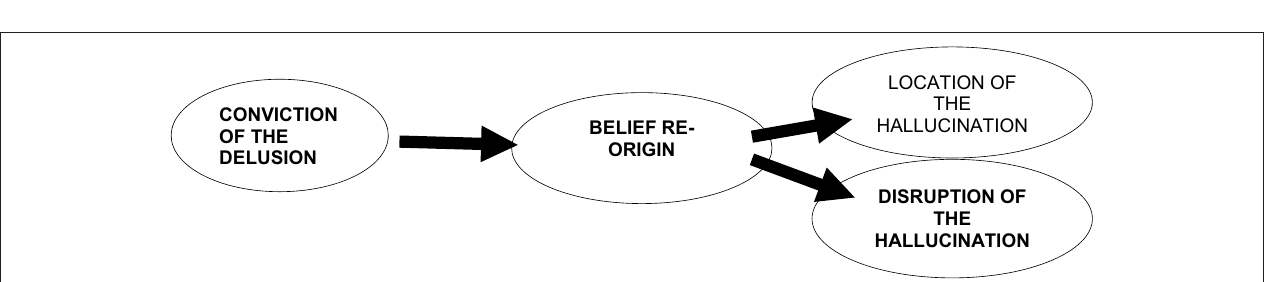
FIGURE 2 | Model of the determinants of the main dimensions of the auditory verbal hallucinations in patients with schizophrenia and schizoaffective disorder.